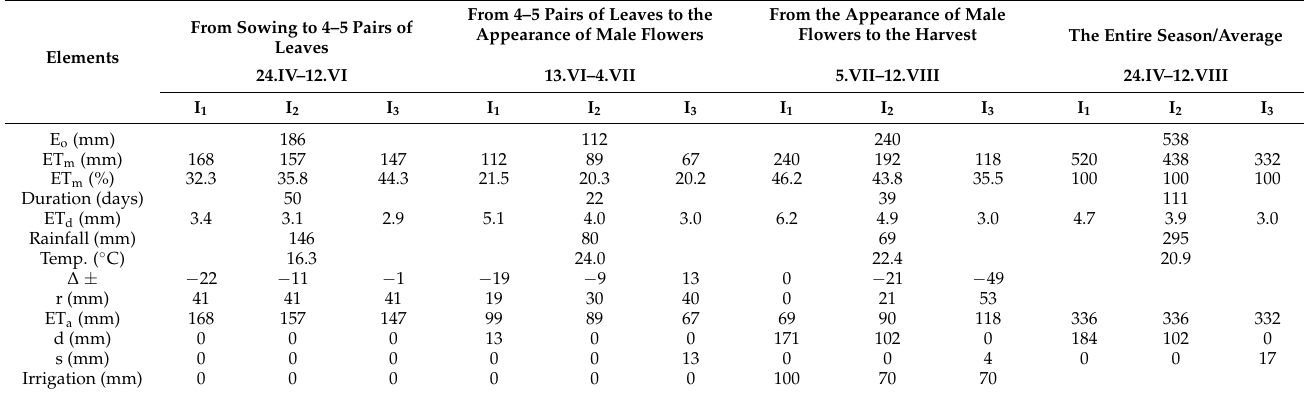
Table 4. Water budget of fiber hemp in